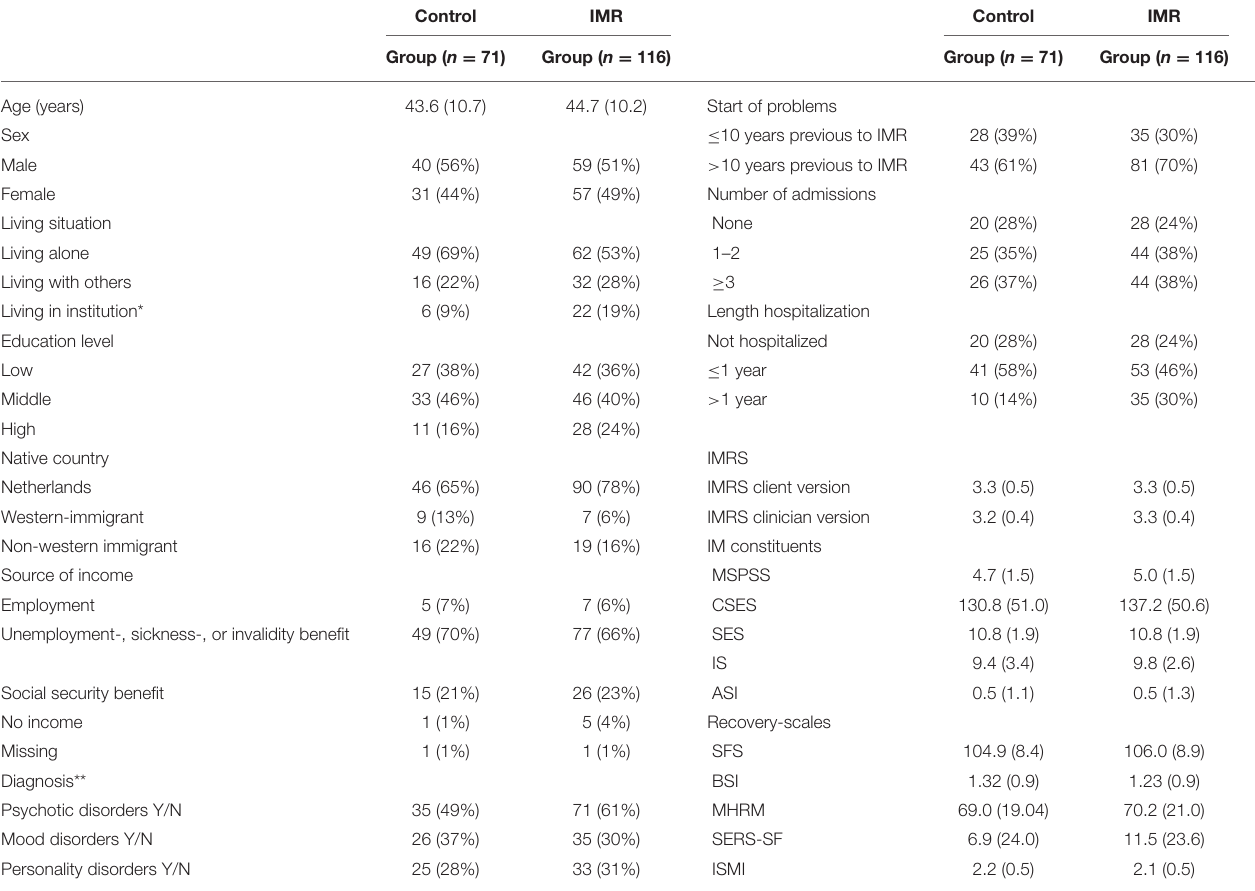
TABLE 1 | Demographic and clinical characteristics of study participants at